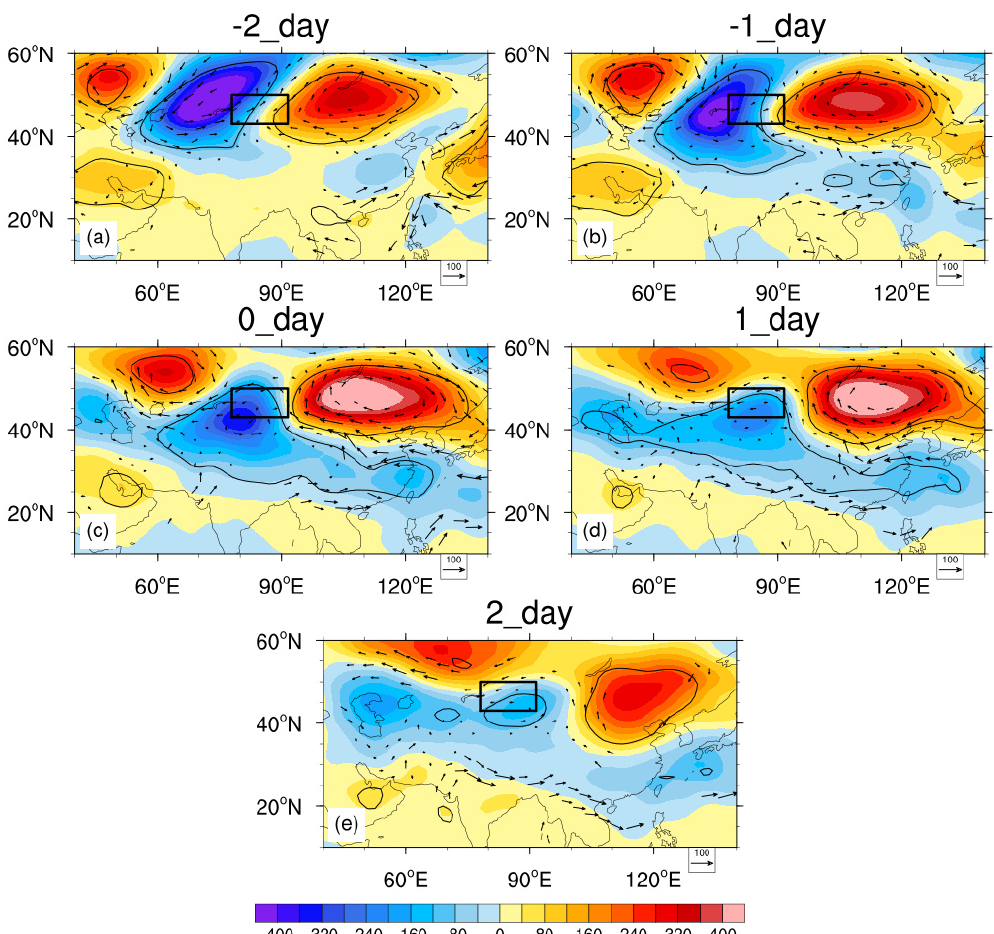
Figure 7. Composition of Z500 (contour) and Q anomaly (arrow) of Type CT on the extreme precipitation day and two days before and after ( a – e ) in the summers of 1979–2018 (Unit: gpm). The black box represents the location of the Northern Xinjiang region. The region over the 95% significant confidence level of geopotential height is circled with black lines, and only the part over the 95% significant confidence level of surface water vapor flux is shown.